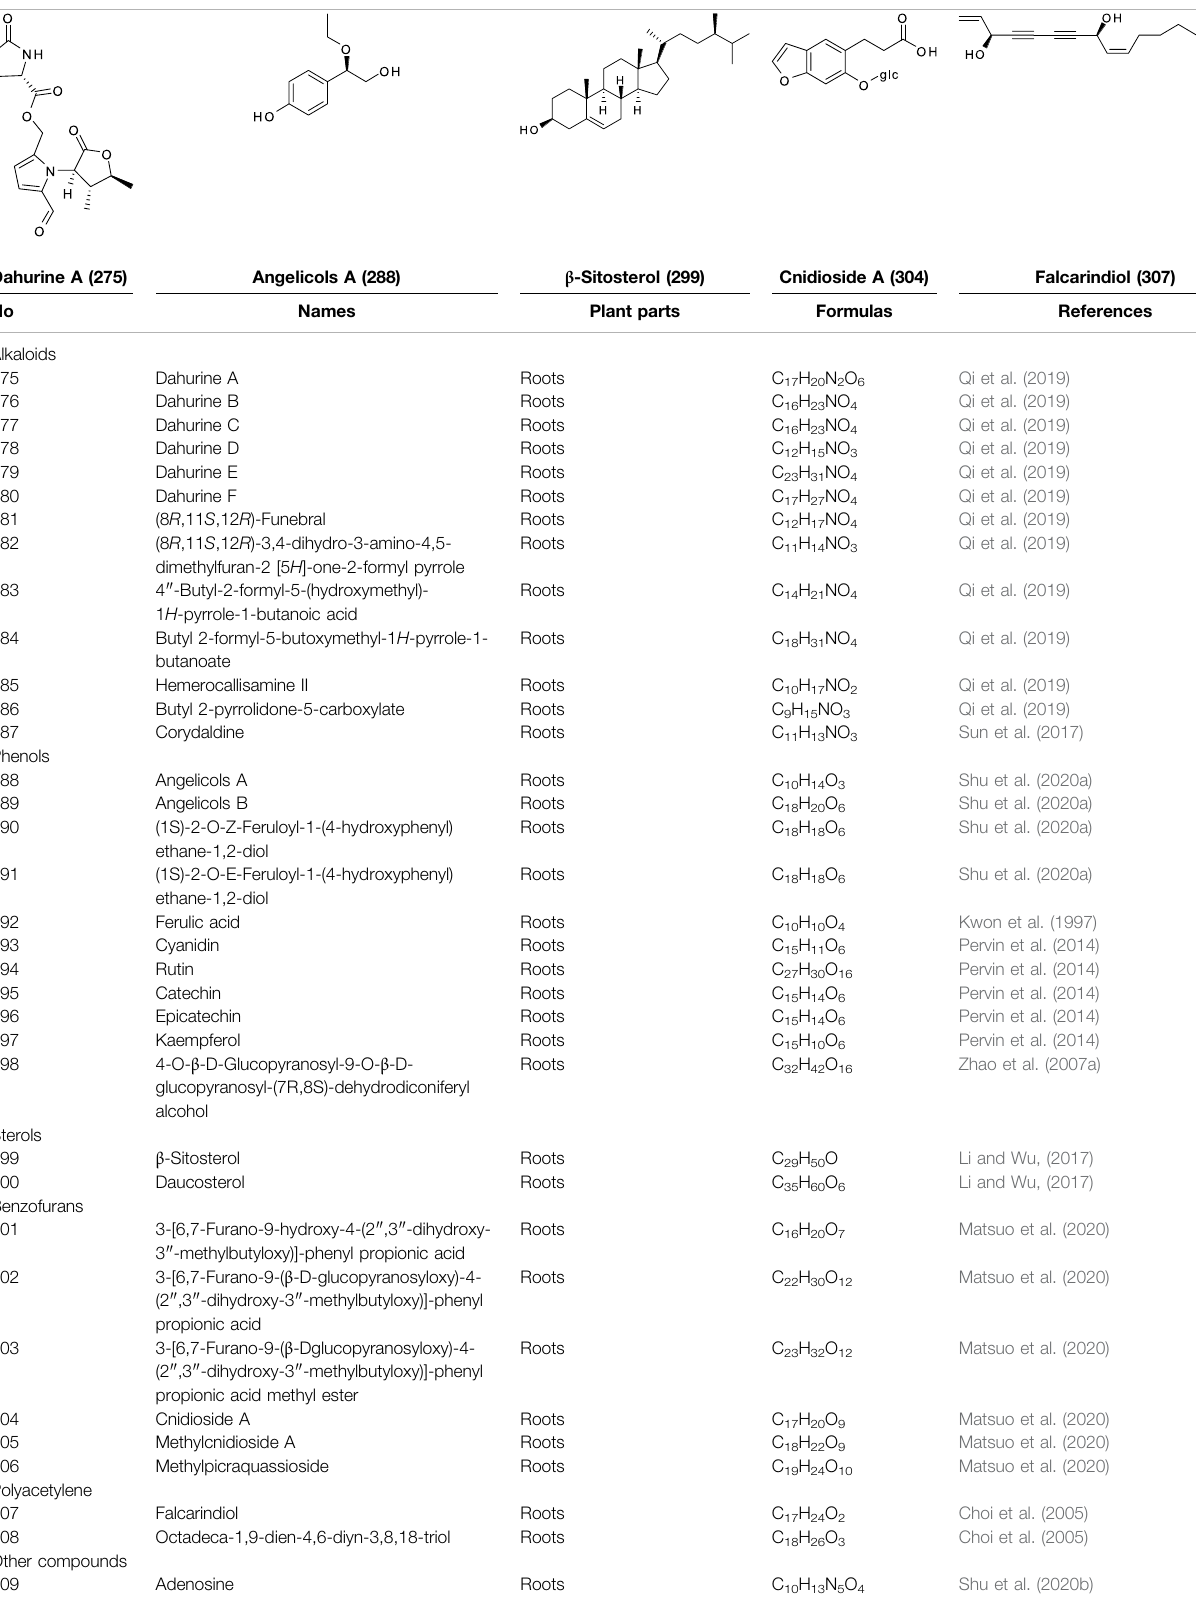
TABLE 5 | Alkaloids, phenols, sterols, benzofurans and polyacetylenes isolated from A. dahurica